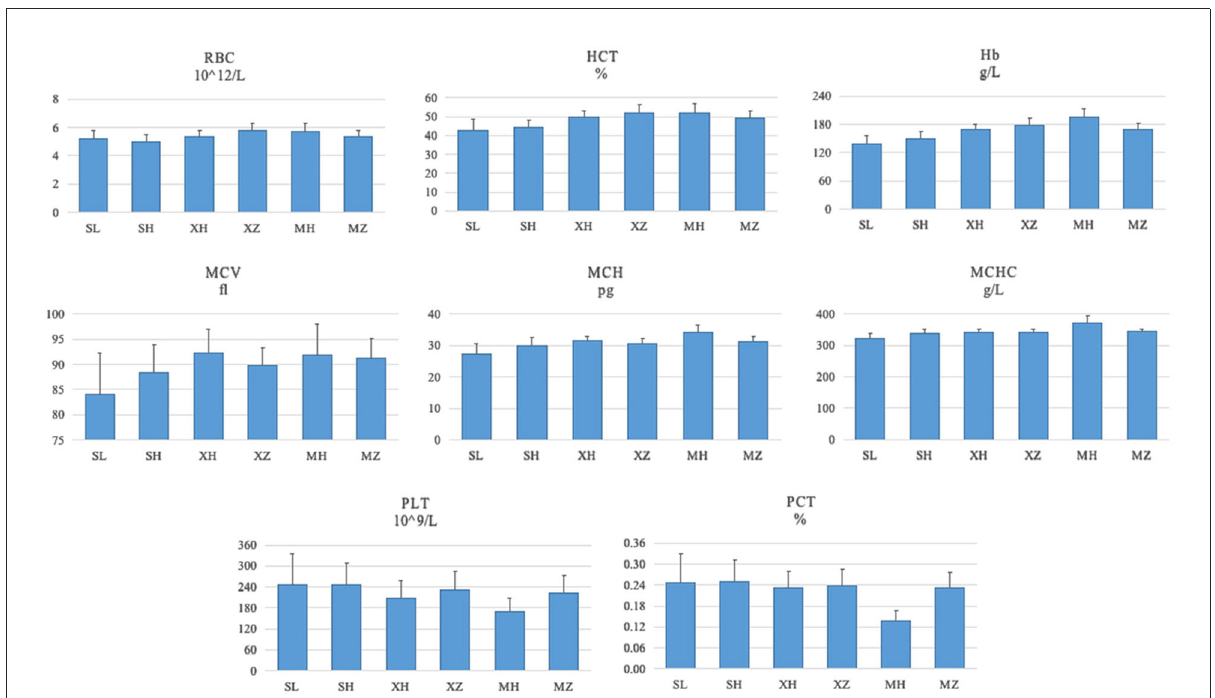
FIGURE1 RBT results of the enrolled population ( x ± s ) . SL, the Sanya Li nationality; SH, the Sanya Han nationality; XH, the Xining Han nationality; XZ, the Xining Tibetan nationality; MH, the Maduo Han nationality; MZ, and the Maduo Tibetan nationality. RBC, red blood cell count; HCT, hematocrit; HB, hemoglobin content; MCV, mean red blood cell volume; MCH, mean red blood cell hemoglobin; MCHC, mean red blood cell hemoglobin concentration; PLT, platelet count; PCT, platelet specific